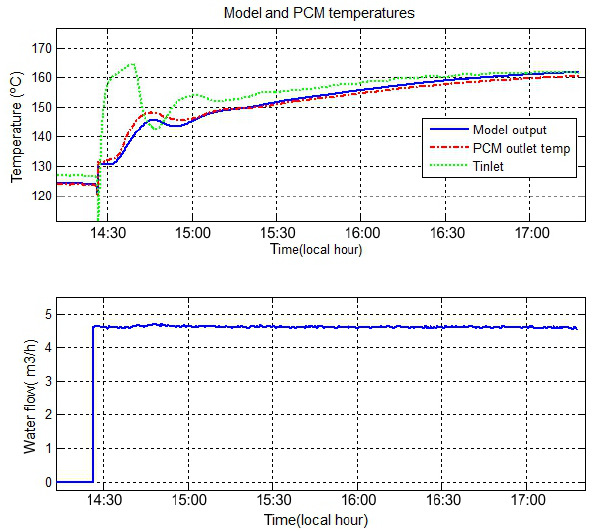
Figure 6. PCM temperature evolution: model vs. real.